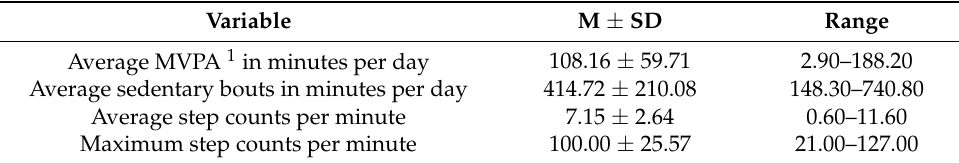
Table 2. Physical activity indices of pregnant adolescents with valid wear ( n =